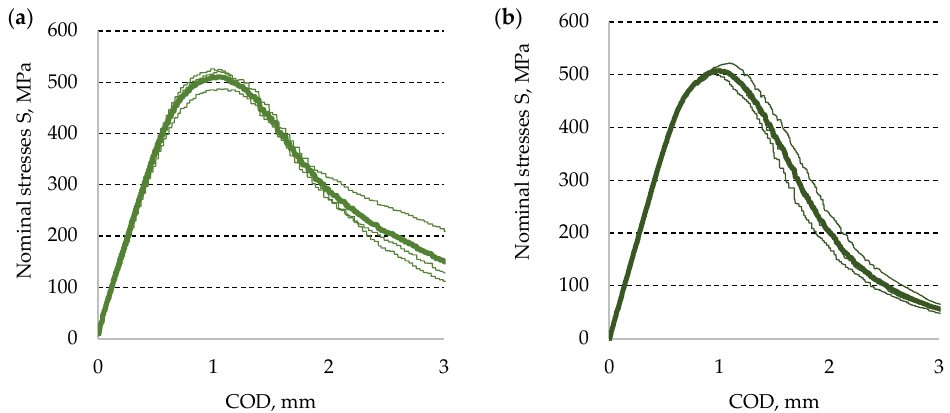
Figure 11. Diagrams of nominal stresses – specimen opening, calculated for AA2519 aluminum alloy: ( a ) ambient conditions and ( b ) cryogenic conditions.